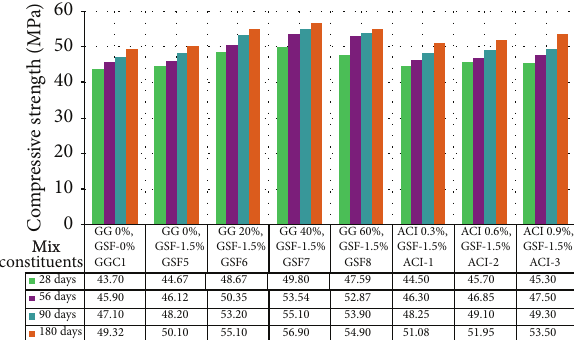
Figure 3: Initial stress applied to concrete specimens.